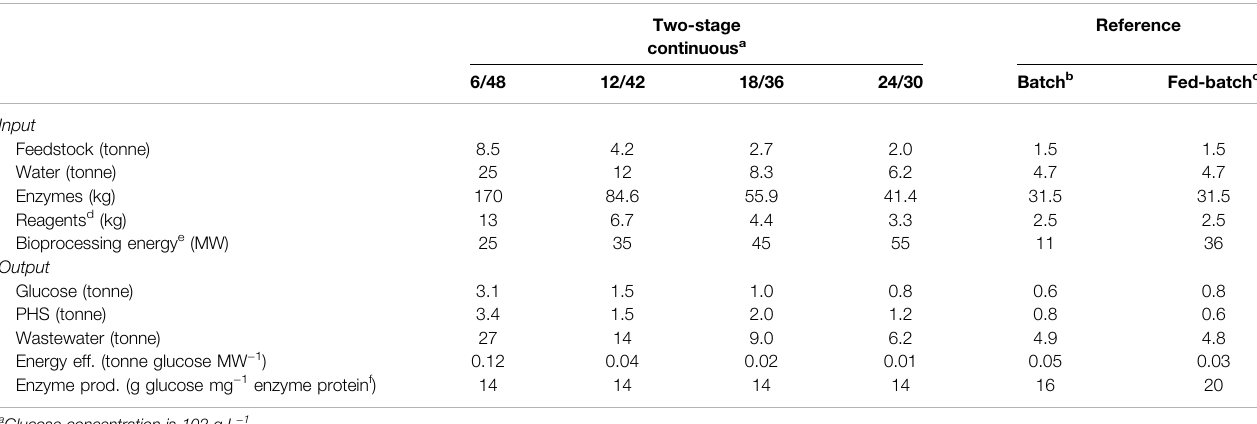
TABLE 2 | Summary of M&E balances of the pilot-scale con fi gurations.